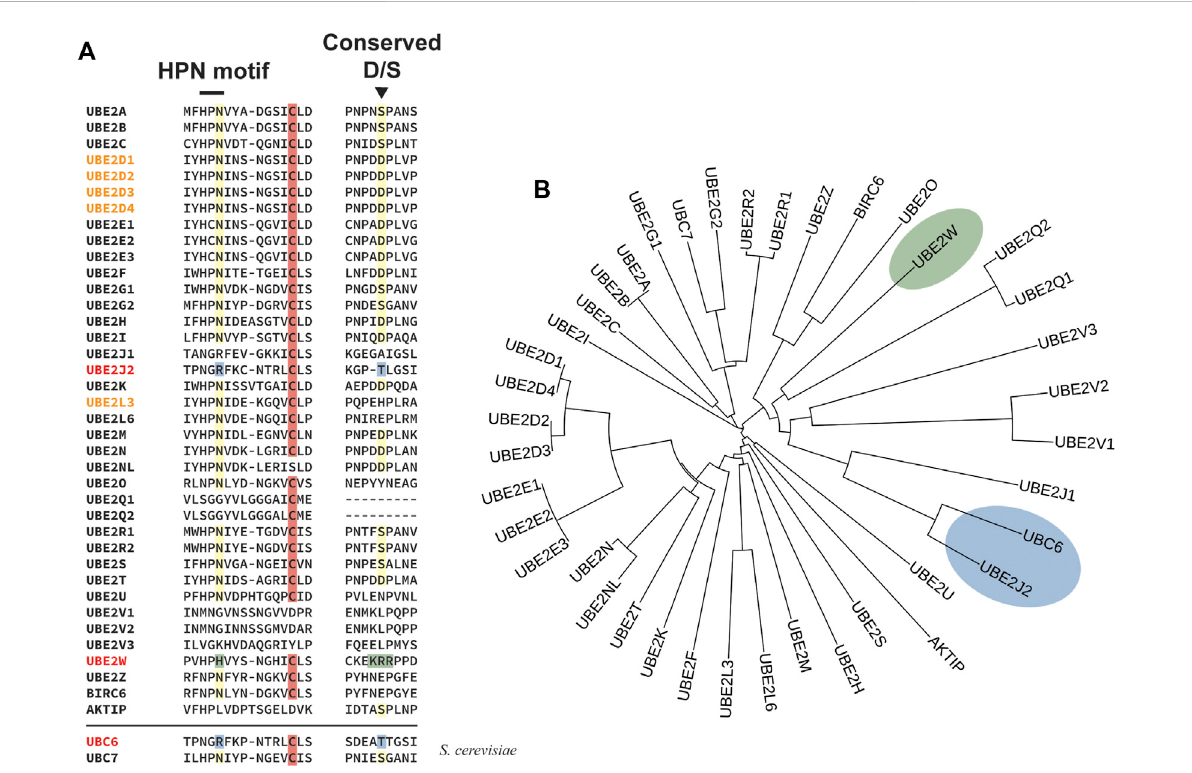
FIGURE 4 Novel sequence features of UBE2W and UBE2J2 that may determine non-canonical speci fi city. (A) A sequence alignment of the residues in selected human and yeast E2s close to the active site cysteine (highlighted in red) reveals that canonical lysine-directed E2s contain a conserved upstream arginine residue(normallypart ofan HPN motif) and adownstream Asp/Ser residue(both highlightedinyellow). E2s knownto ubiquitylate hydroxylated residues are written in red and notably differ in the amino acids present at these sites. Divergent catalytically-important amino acids in UBE2W are highlighted in green, including the basic cluster that replaces the conserved D/S residue. The equivalent residues in UBE2J2 and its yeast homologue UBC6 are highlighted in blue. The names of E2s involved in transthiolation of cysteine residues are written in orange. Sequence alignments were performed using the Clustal Omega server (Sievers and Higgins 2021) and manually edited where necessary to match known structural information (Gundogdu and Walden 2019). (B) Phylogenetic tree depicting relationships between the selected E2s shown in (A) . The non- canonical ERAD-related E2 conjugating enzyme UBE2J2 and its yeast homologue UBC6 are highlighted in blue, UBE2W is highlighted in green. Analysis was performed by aligning the ubiquitin-conjugating UBC fold of selected E2s in Clustal Omega and is displayed using iTOL (Letunic and Bork